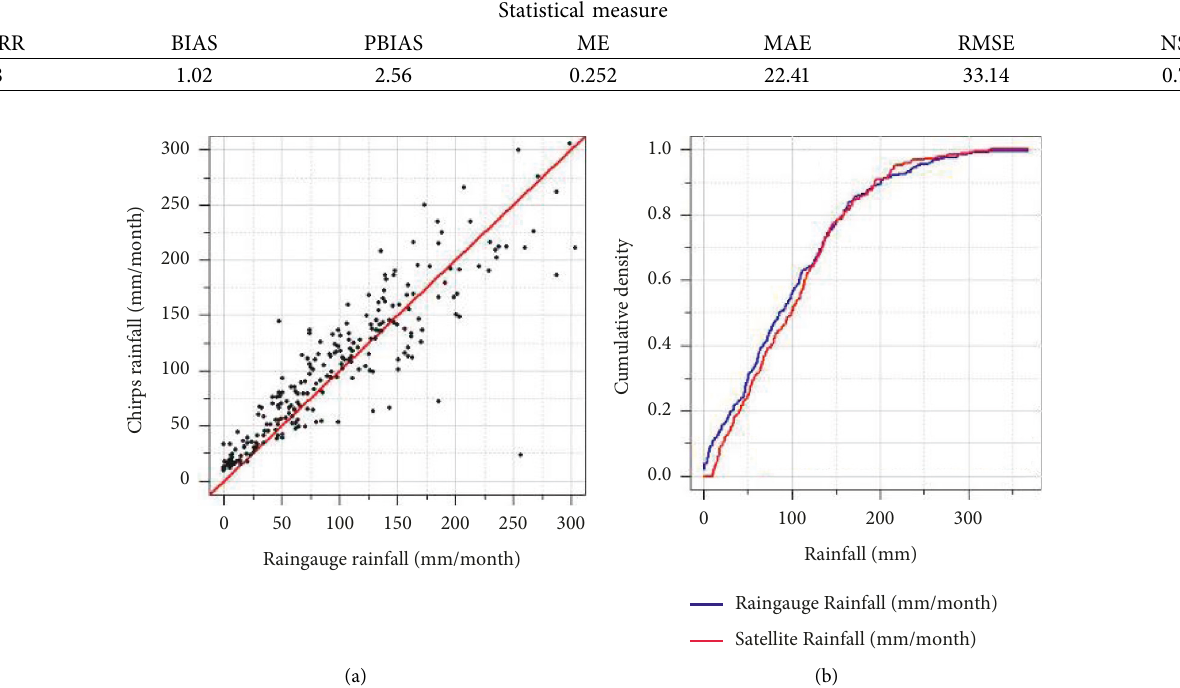
Figure 4: Scatter plot (a) and cumulative distribution function plot (b) comparison of monthly rainfall CHIRPS satellite rainfall estimates and rain gauge for 2000–2020 (spatial